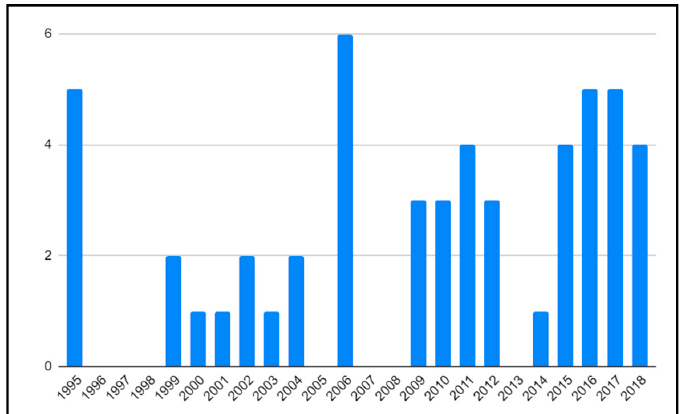
Figure 1. Number of publications by year.